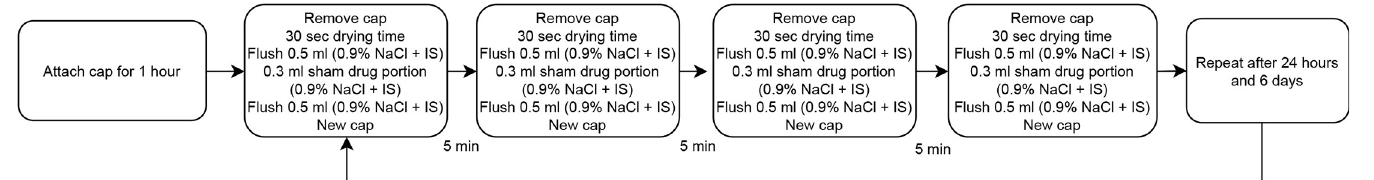
Fig 2. Injection scheme for IPA circuits. IS = Internal standard.